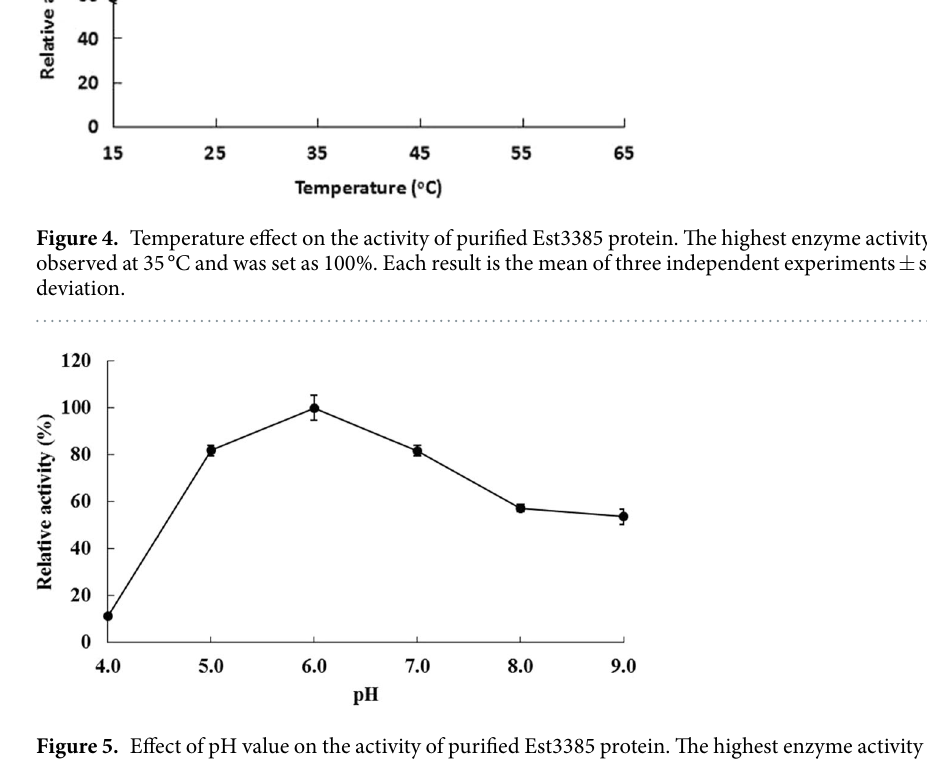
Figure 5. Effect of pH value on the activity of purified Est3385 protein. The highest enzyme activity was observed at pH 6.0 and was set as 100%. Each result is the mean of three independent experiments ± standard